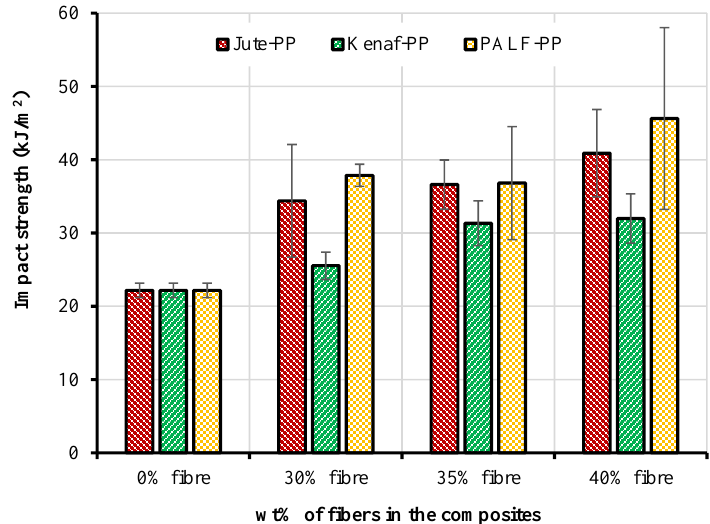
Figure 10. Impact strengths of the natural fiber-reinforced PP composites.